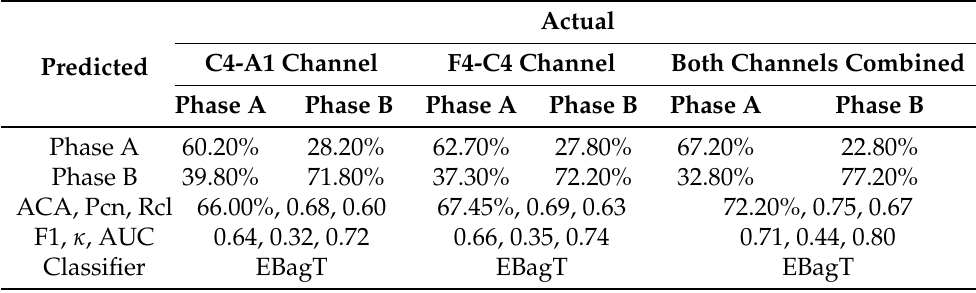
Table 9. Classification performance for RBD